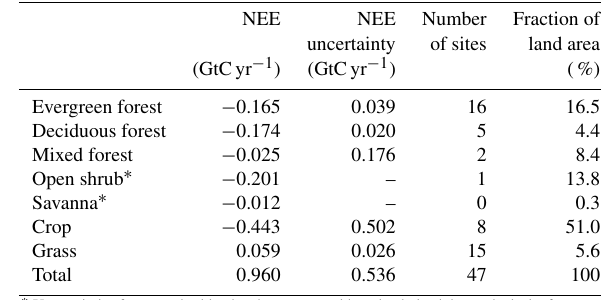
Table 4. Results from jackknife delete-1 statistics for VPRM es- timated domain-wide NEE for different vegetation classes and for all of the land area. The uncertainty in NEE from all land area was derived assuming independence in the vegetation-class-specific un- certainties. Note the strong asymmetry between the fraction of land area covered by the different vegetation classes and the number of eddy covariance sites used, indicating over- and underrepresenta- tion: for example, 8 crop sites represent 51% of the land area, while 15 grassland sites represent 5.6% of the land area of